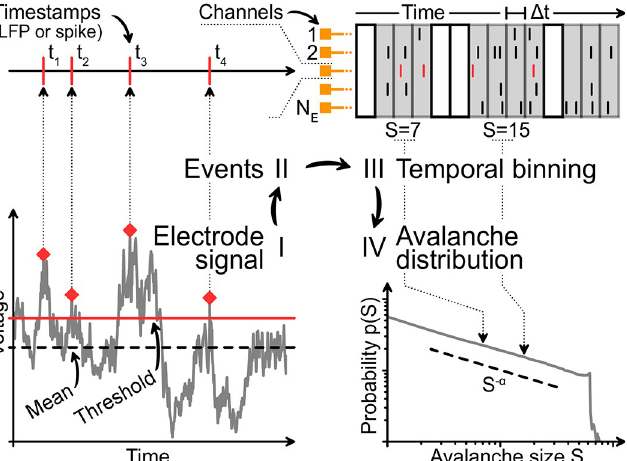
Fig 2. Analysis pipeline for avalanches from sampled data. I : Under coarse-sampling (LFP-like), the recording is demeaned and thresholded. II : The timestamps of events are extracted. Under sub-sampling (spikes), timestamps are obtained directly. III : Events from all channels are binned with time-bin size Δ t and summed. The size S of each neuronal avalanche is calculated. IV : The probability of an avalanche size is given by the (normalized) count of its occurrences throughout the recording.